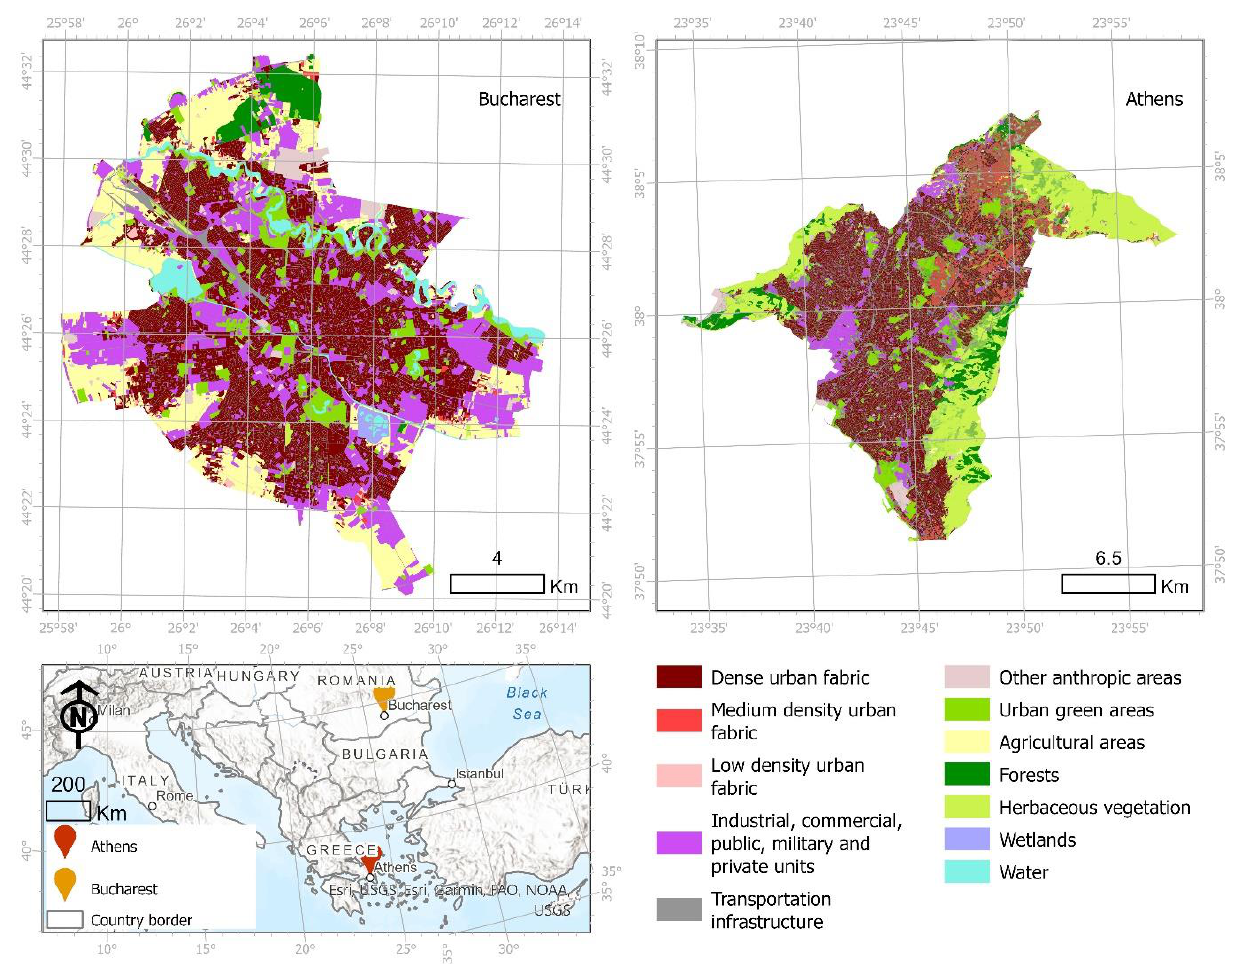
Figure 1. Location of the case studies and main land use categories, based on Urban Atlas data (Data from [35]).